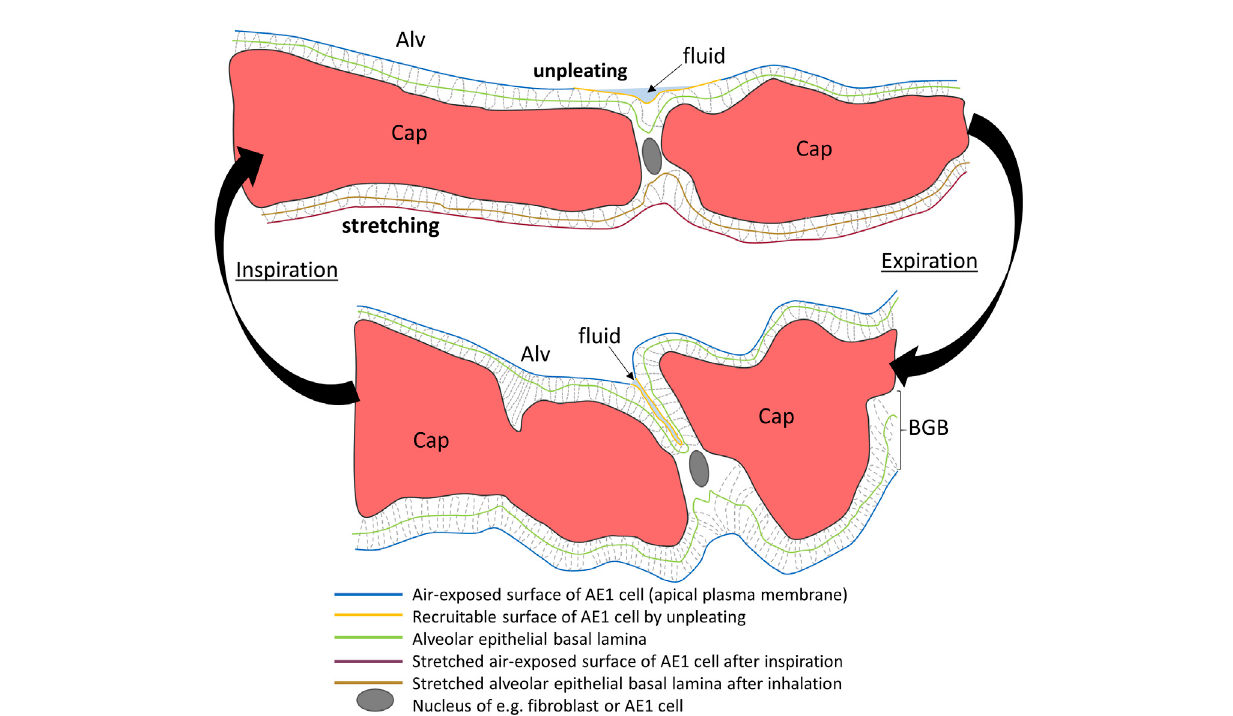
FIGURE 13 Micromechanics of the blood-gas barrier. Schematic of an interalveolar septum at end-expiration (bottom) and end-inspiration (top). The end- expiratory drawing is based on an electron microscopic image and shows in the upper blood-gas barrier (BGB) a pleat fi lled with fl uid (light blue). The surfaceareaoftheinvolvedalveolarepithelialcellishiddeninthepleat(yellow)andnotexposedtoair.Afterinspiration,thepleathasbeenopenedandits surface area, although still covered by fl uid is now exposed to the alveolar lumen. As a result, there is an increase in surface area and adaptation to changing alveolar size without stretching of the alveolar epithelial cell or the epithelial basement membrane (green). The BGB at the bottom of the septum however, does not have a pleat. The BGB is therefore stretched during inspiration which results in an increase in the surface area of both air- exposed apical membranes of alveolar epithelial cells and epithelial basement membrane. The BGB is thinned due to stretching. Capillaries (Cap) andthe BGB are also subject to shape changes to adapt to an increase in alveolar volume during inspiration which do not result in an increase in the surface area ofthebasementmembraneorapicalplasmamembraneofepithelialcells.Thisschematicisbasedonclassicaltransmissionelectronmicroscopicimages which are not able to visualize the complete liquid lining layer. Please note, that the fi xation process with glutaraldehyde is based on cross-linking of proteins. Hence, only those parts of the liquid lining layer which contain proteins can be visualized and are given in this